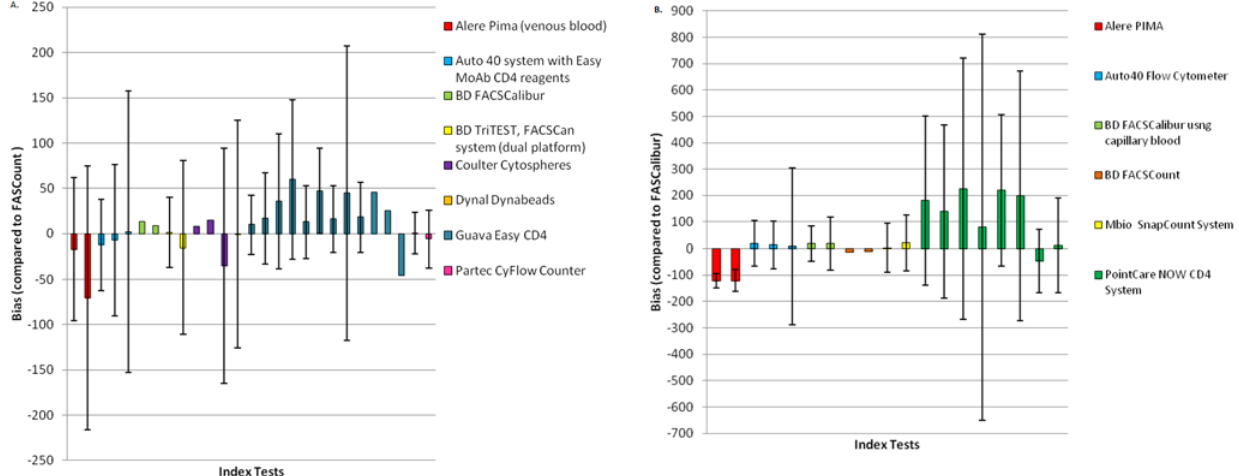
Fig 3. A. Bias compared to FASCount as the reference technology. B. Bias compared to FASCalibur as the reference